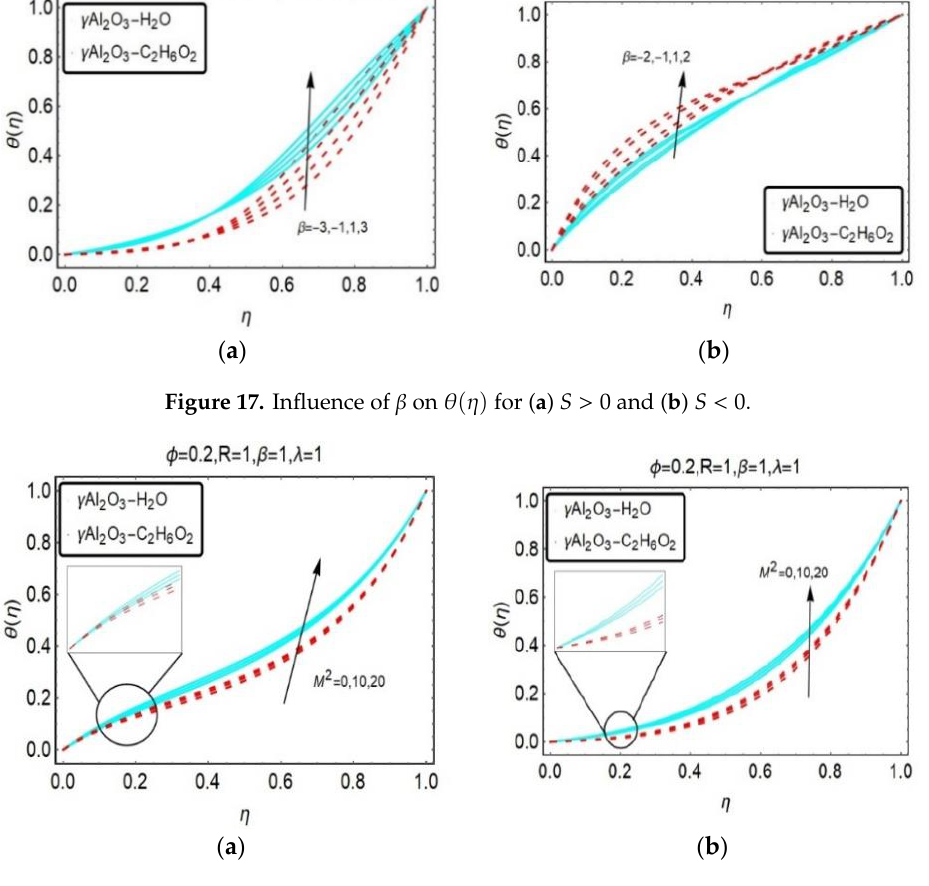
( b ) Figure 15. Influence of 𝜙 on 𝑔(𝜂) for ( a ) 𝑆 > 0 and ( b ) 𝑆 < 0 . The upshots of embedding parameters such as Prandtl number, volume fraction, magnetic parameter, ratio of characteristic parameter to stretching factor, rotation parameter, and mixed convection parameter on temperature profile 𝜃(𝜂) are illustrated in Figures 16–21. In Figures 16–21, for both the suction and injection cases, the temperature profile enhanced with increasing value of these pertinent parameters except Figure 19b. Prandtl number also influences the temperature field of nanofluids like water and ethylene glycol suspended with gamma- 𝐴𝑙 2 𝑂 3 nanoparticles in increasing manner for both inhalation and injection.